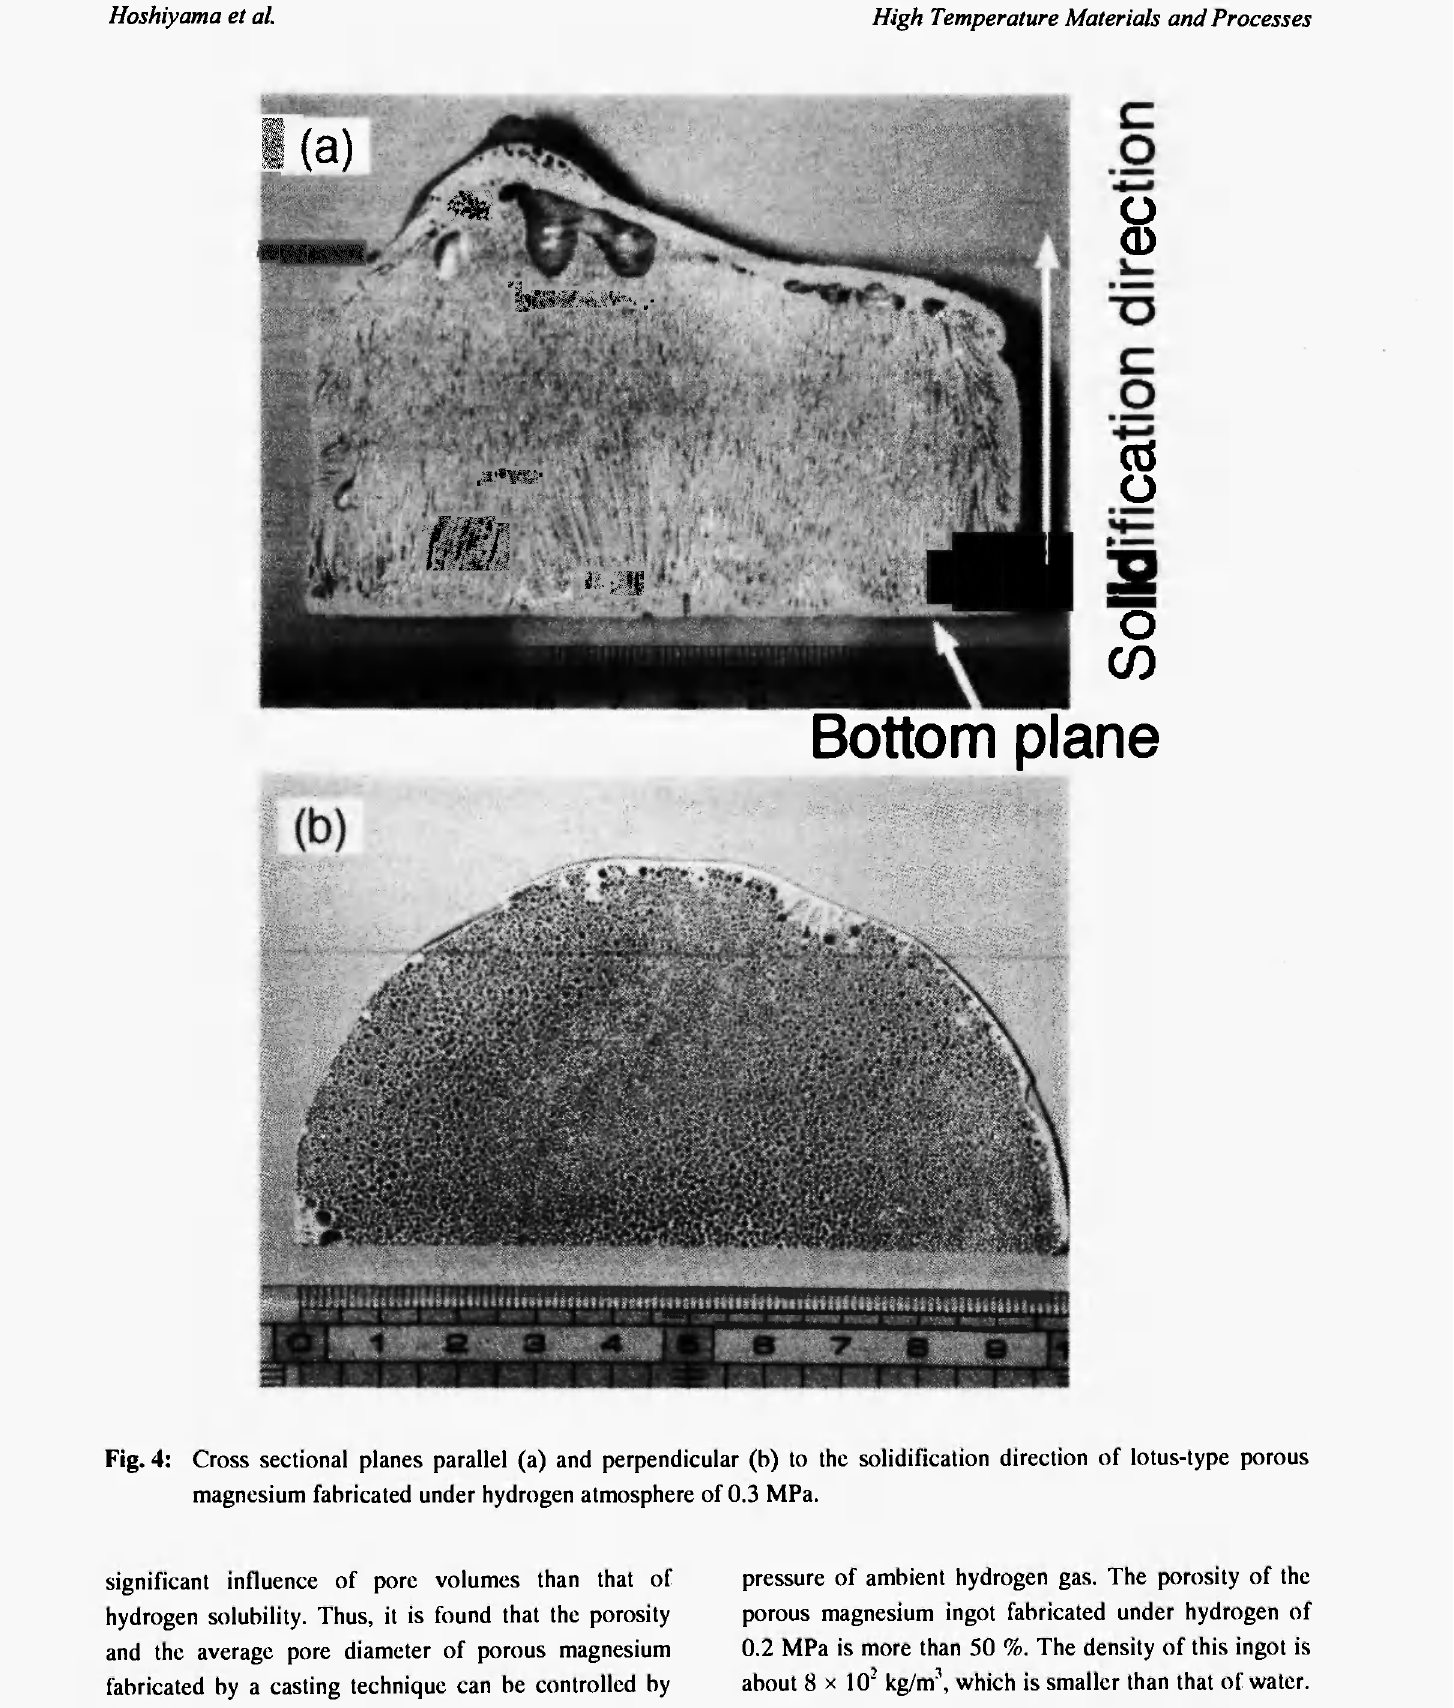
pressure of ambient hydrogen gas. The porosity of the porous magnesium ingot fabricated under hydrogen of 0.2 MPa is more than 50 %. The density of this ingot is about 8 χ 10 2 kg/m\ which is smaller than that of water.